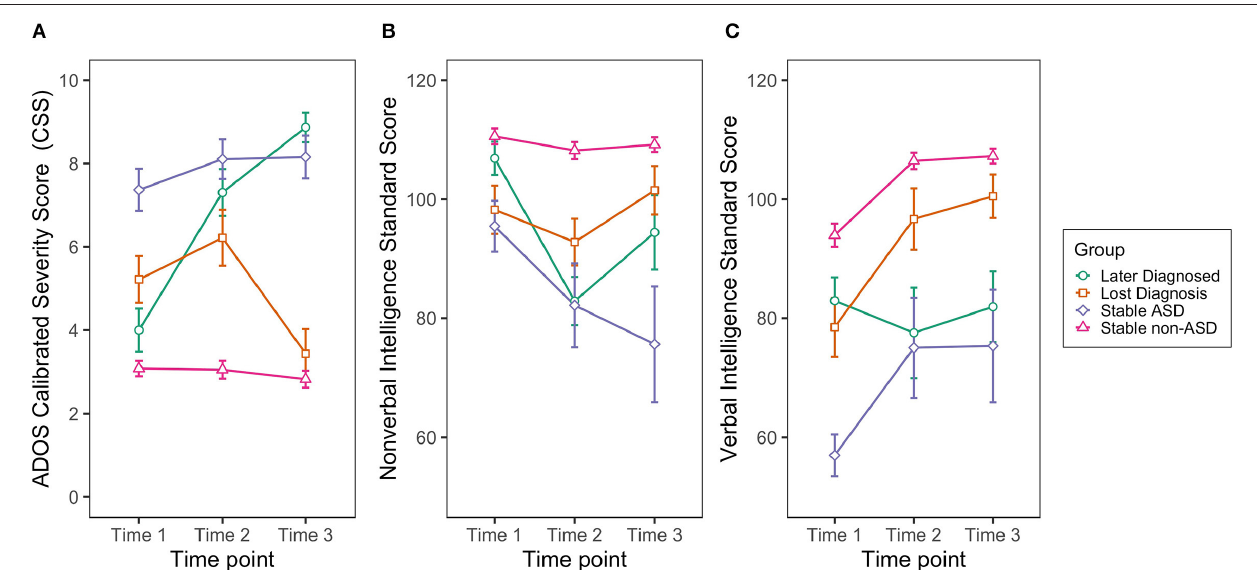
FIGURE 1 | Developmental trajectories of the (A) Autism Diagnostic Observation Schedule Calibrated Severity Score (ADOS-CSS); (B) Non-verbal and (C) Verbal Intelligence (IQ) by group. Non-verbal IQ: Times 1 and 2 = Mullen Scales of Early Learning (MSEL) non-verbal developmental quotient; Time 3 = Stanford-Binet Intelligence Scales, Fifth Edition (SB-5) non-verbal intelligence standard score. Verbal IQ: Times 1 and 2 = MSEL verbal developmental quotient; Time 3 = SB-5 verbal intelligence standard score. Error bars denote ± SEM.